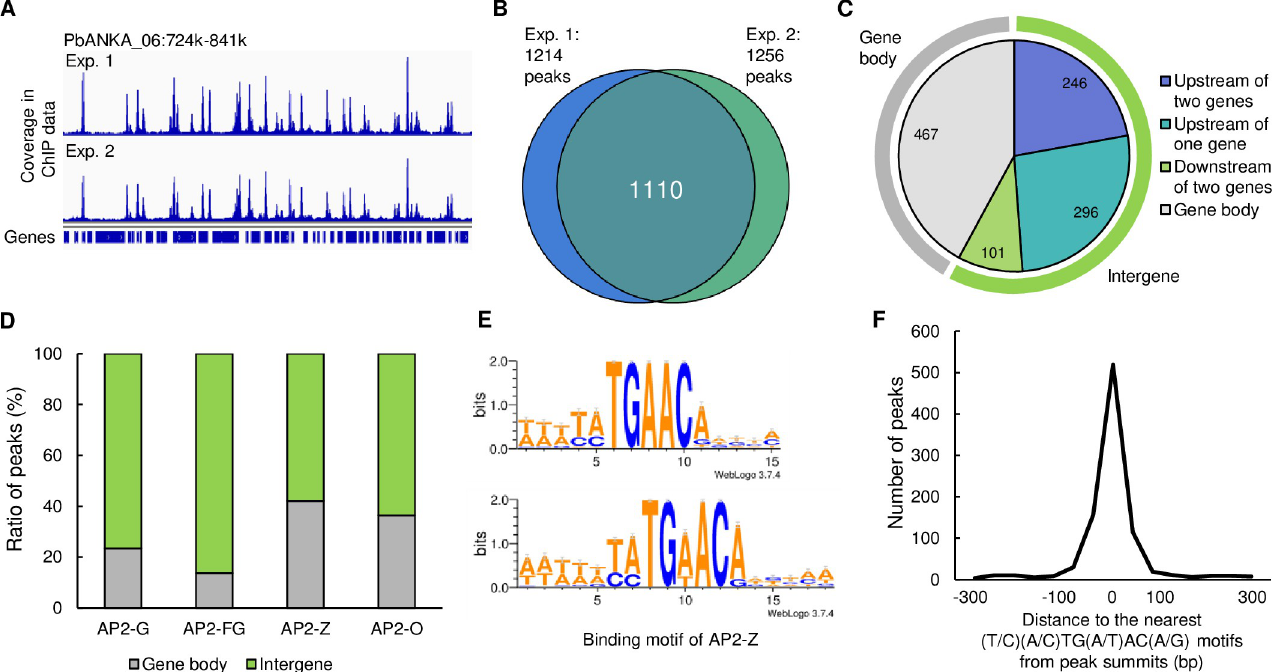
Fig 4. ChIP-seq analysis of AP2-Z. (A) Integrative Genomics Viewer images from ChIP-seq experiment 1 and 2 of AP2-Z in a part of chromosome 6. Histograms show sequence coverage of ChIP data at each base. (B) Venn diagram of number of peaks identified in ChIP-seq experiment 1 and 2. (C) Classification of peak locations. Light green and gray bars around the pie chart indicate the intergenic region and gene body region, respectively. (D) Ratio of peaks located on the gene body and intergenic region for ChIP-seq of AP2-G, AP2-FG, AP2-Z, and AP2-O. (E) Sequence logo constructed from TGAAC motifs in the peak regions (top) and predicted binding motif of AP2-Z (bottom). Sequence logos are depicted using WebLogo 3 (http://weblogo.threeplusone.com/ create.cgi). (F) Histogram showing the distance between the peak summit and the nearest (T/C)(A/C)TG(A/T)AC(A/G) motif for each ChIP peak.